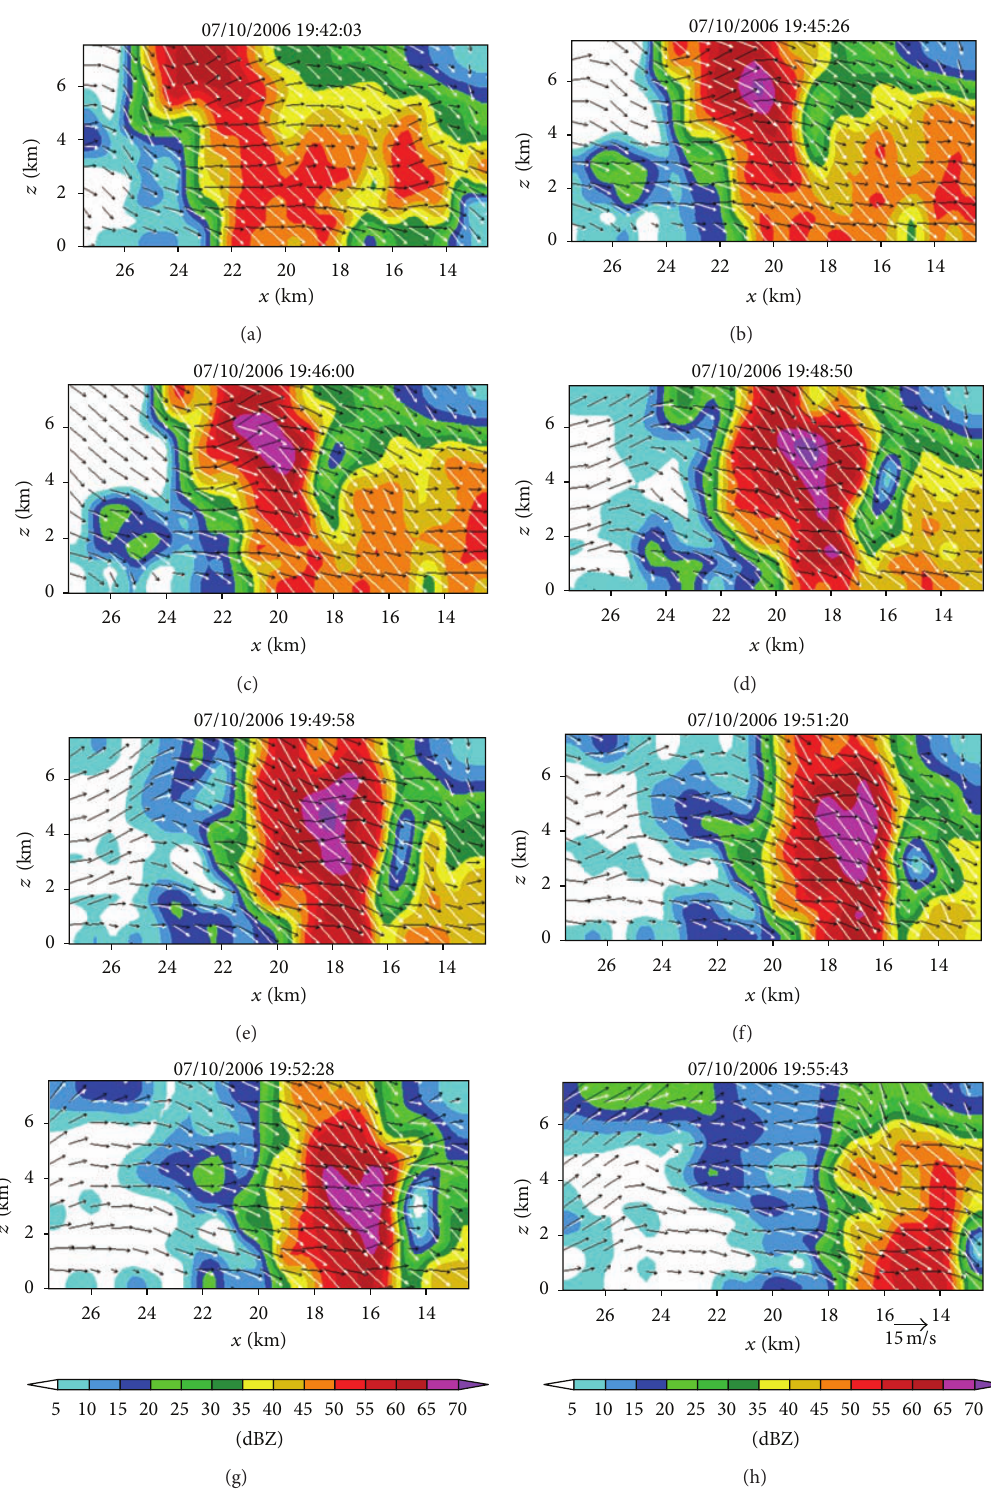
Figure 6: Time series of retrieved ( 𝑢 𝑚2 ,𝑤 𝑎 𝑚 ) fields for air motions (plotted by black arrows) in the vertical cross-section (along the 𝑥 - coordinate in Figure 4) superimposed on the PAR-observed reflectivity fields (gridded and smoothed by the spatial interpolation in the vertical cross-section) from 19: 42: 03 to 19: 55 :43 UTC on July 10, 2006. The white arrows plot the vector velocities of hydrometeors (i.e., air velocity plus the hydrometeors’ downward terminal